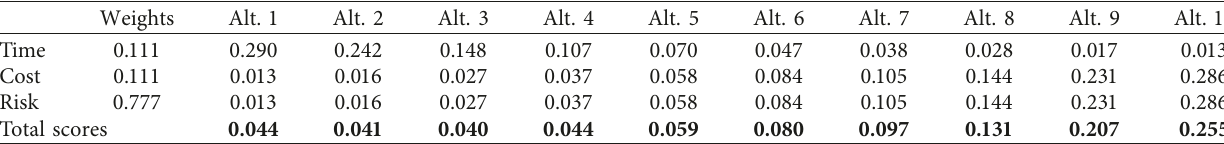
Table 4: Results of the FMCDM model (case one).